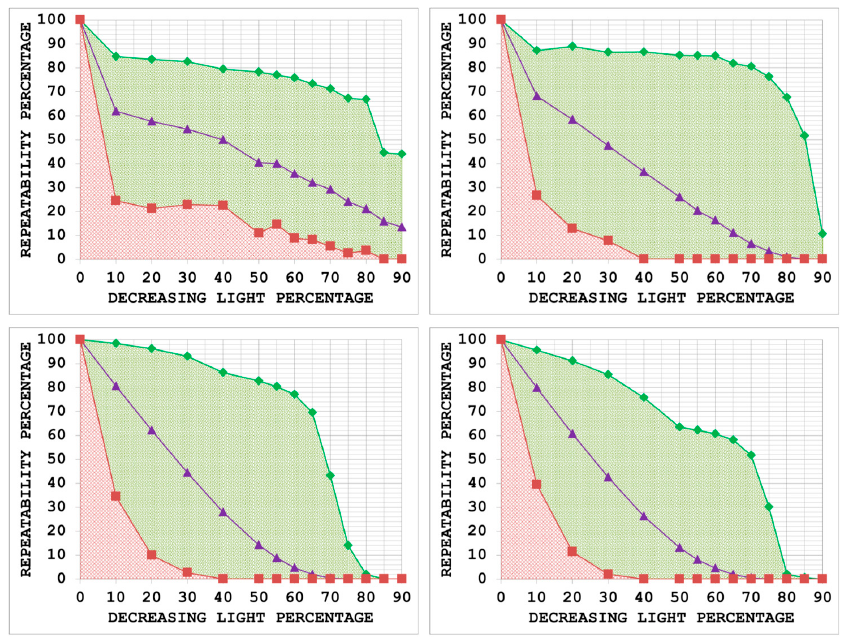
Figure 8. Results for uniform light variations utilizing the proposed framework and the image database for Salient ( top left ), EBR ( top right ), Harris-Affine ( bottom left ) and Hessian-Affine ( bottom right ) detectors.